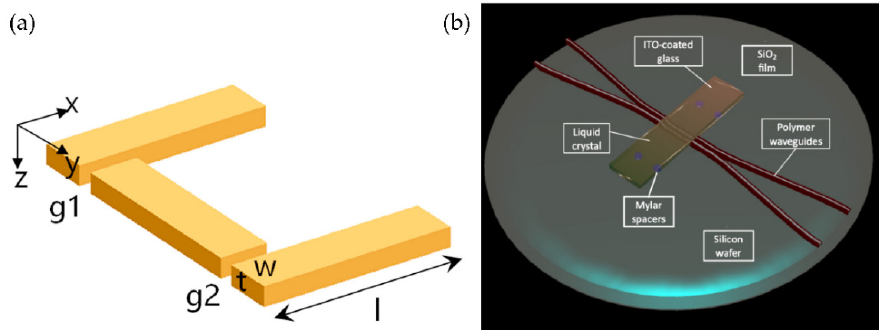
Figure 21. Optical switch structure: ( a ) nanometal structure [92] and ( b ) MMI channel switching control [93]. Reprinted with permission from Ref. [92,93]. 2017 Elsevier and 2019 Beilstein-Institut.